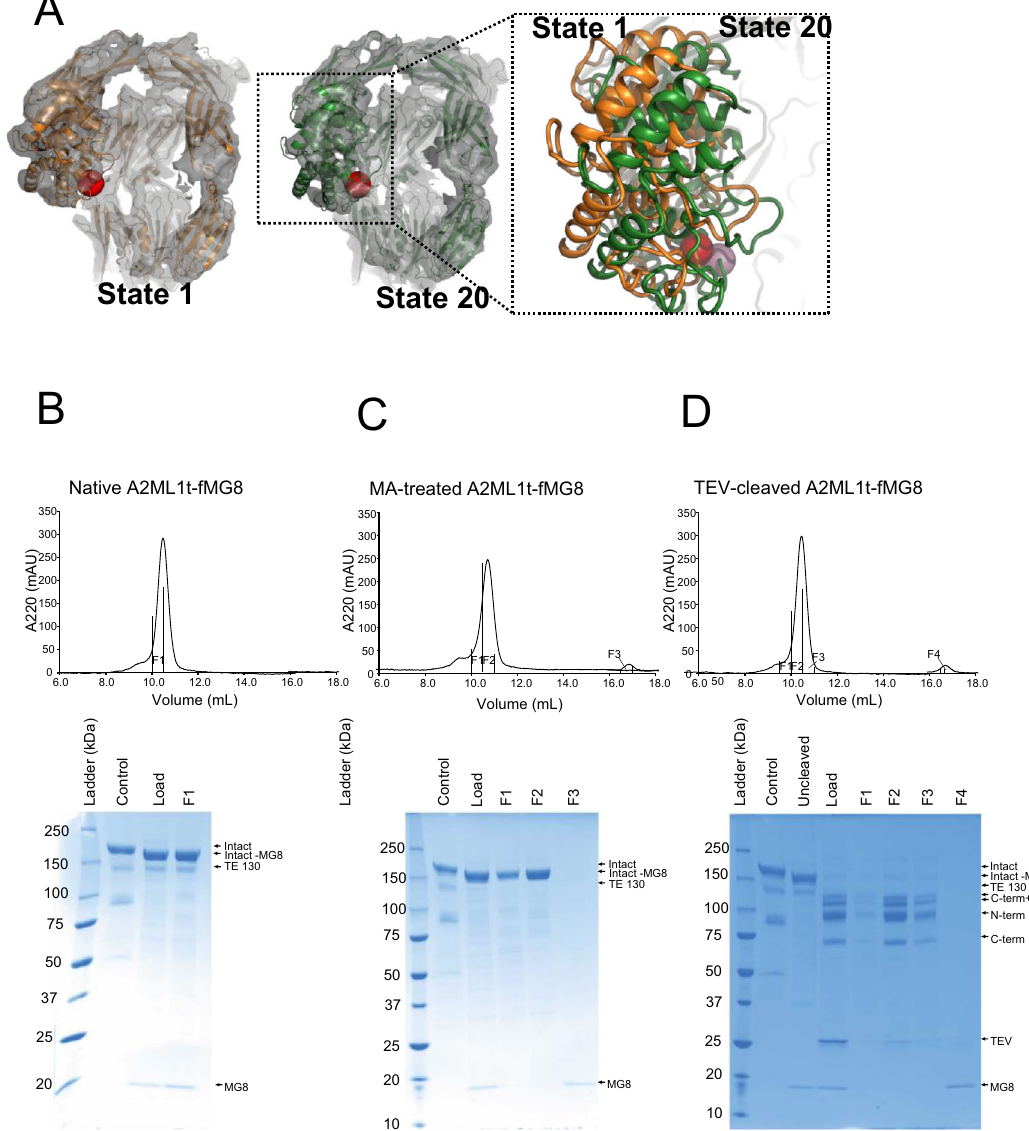
Fig. 5 The MG8 domain is fl exibly attached to the rest of cleaved A2ML1. A The two most extreme states observed in a 3D variability analysis of the A2ML1-CC with map and models superimposed. Except for the TE and CUB domains, only limited differences between the two states are observed. In the magni fi ed view, the extreme positions of the TE domain are compared. B – D SDS-PAGE analyses of selected fractions from the SEC runs with native, methylamine-activated, and TEV-P cleaved A2ML1t-fMG8. Native A2ML1 was used as a control during SDS-PAGE analysis. The identities of the speci fi c bands on the SDS-PAGE gels were con fi rmed by LC-MS/MS. In native A2ML1t-fMG8, the MG8 domain co-elutes with the rest of A2ML1 during SEC despite furin cleavage between CUB and MG8 (panel B ), while the MG8 domain elutes independently of the rest of A2ML1 during SEC after activation by methylamine or TEV-P (panels C , D ). This experiment was performed